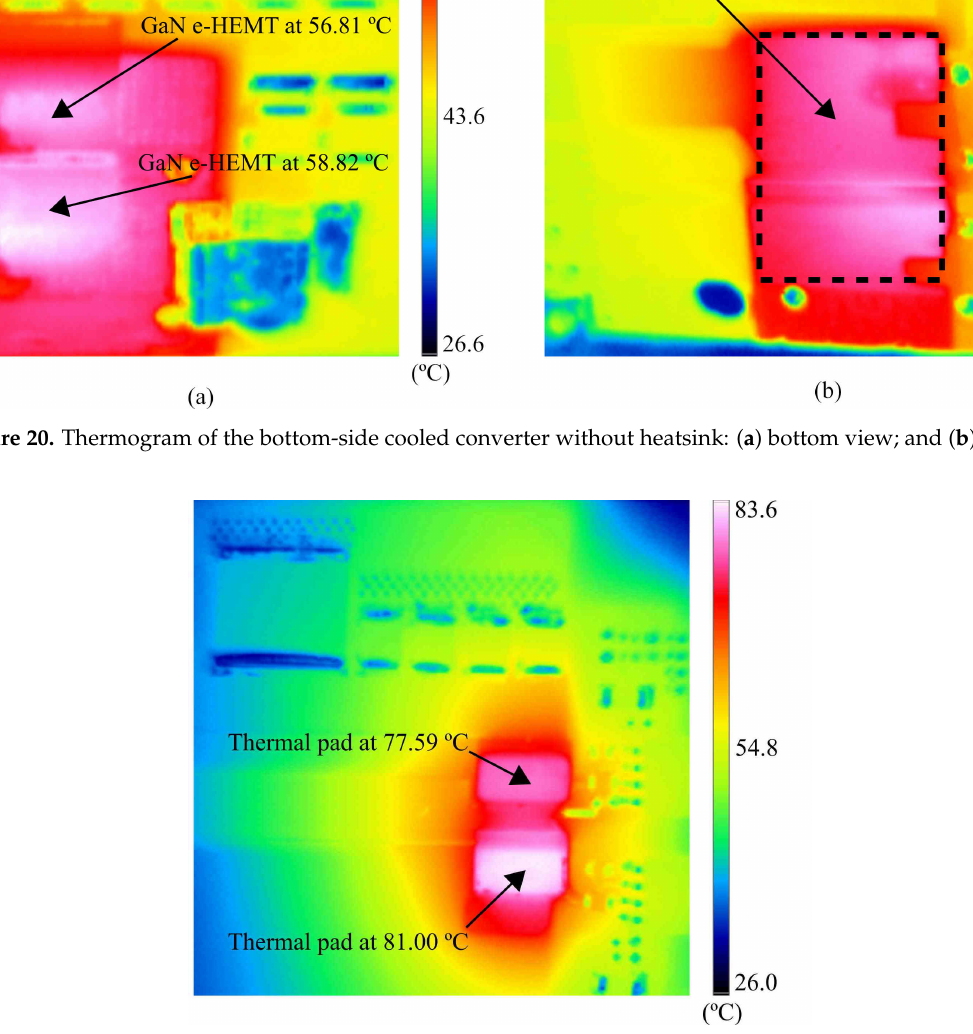
Figure 21. Thermogram of the top-side cooled converter without